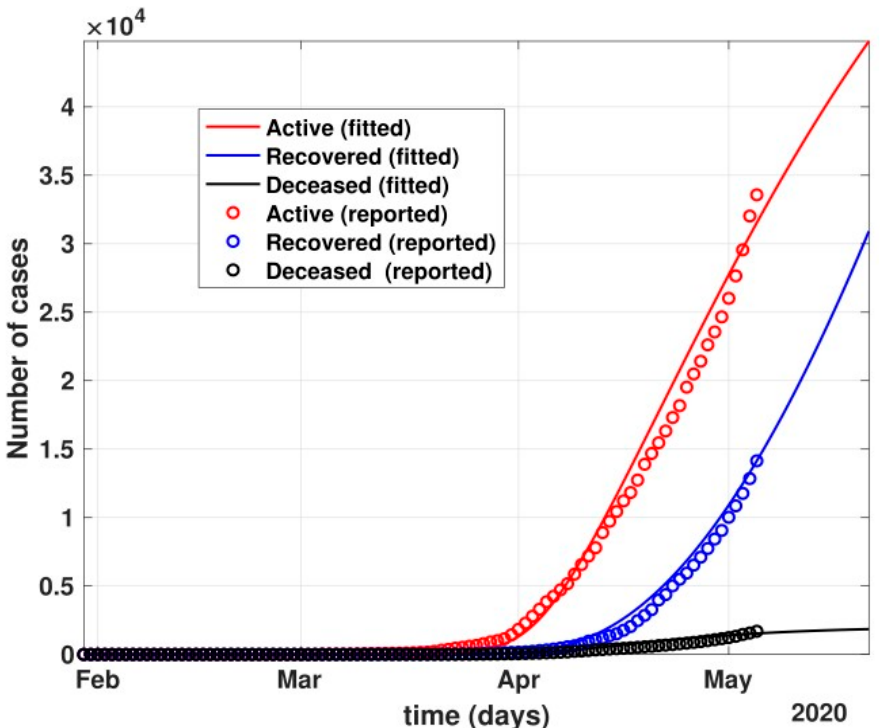
Figure 7. The prediction of fit of the proposed model described by system (1) for COVID-19 data